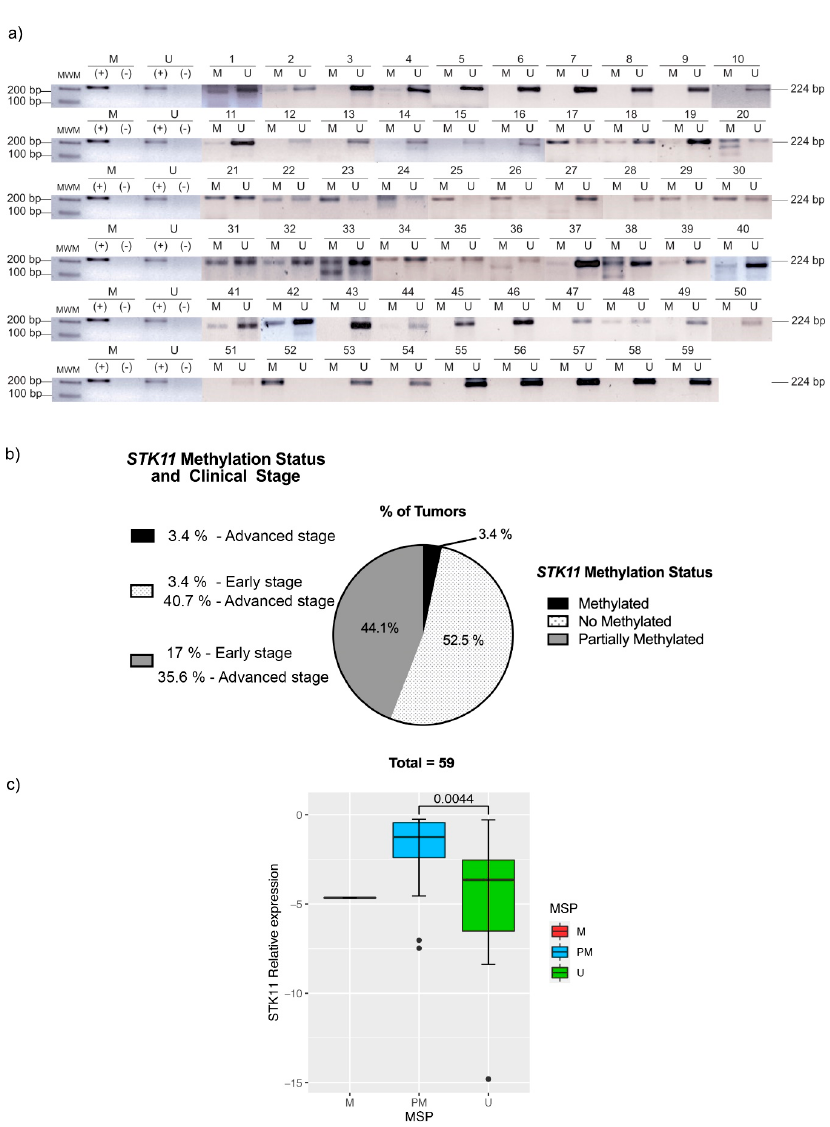
Figure 2. Methylation status of STK11 assessed by MSP ‐ PCR in patients with HNC. ( a ) End ‐ point PCR of each sample, and ( b ) the proportion of methylated versus non ‐ methylated and partially methylated samples. M: methylated, U: unmethylated, ( − ): negative control, (+): positive control, as well as the clinical stage per group. ( c ) Boxplot of the relative expression of STK11 between the MSP groups.